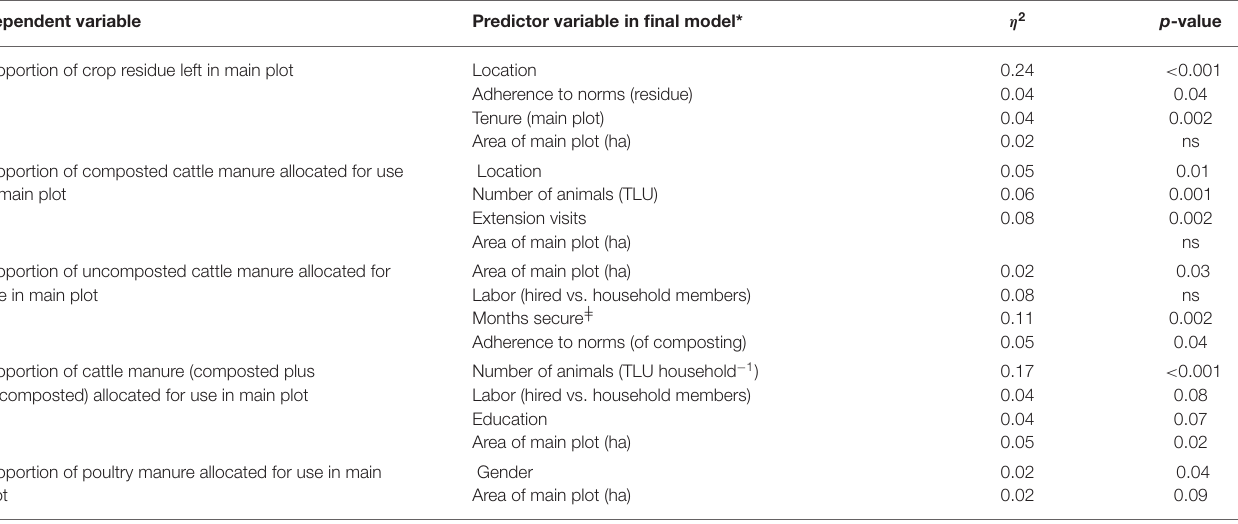
TABLE 7 | Farm-level predictors selected using a stepwise regression that explain variation in the proportion of crop residues retained, cattle and poultry manure applied to the main plot in Nandi, Vihiga, and Busia counties of western Kenya. Dependent variable